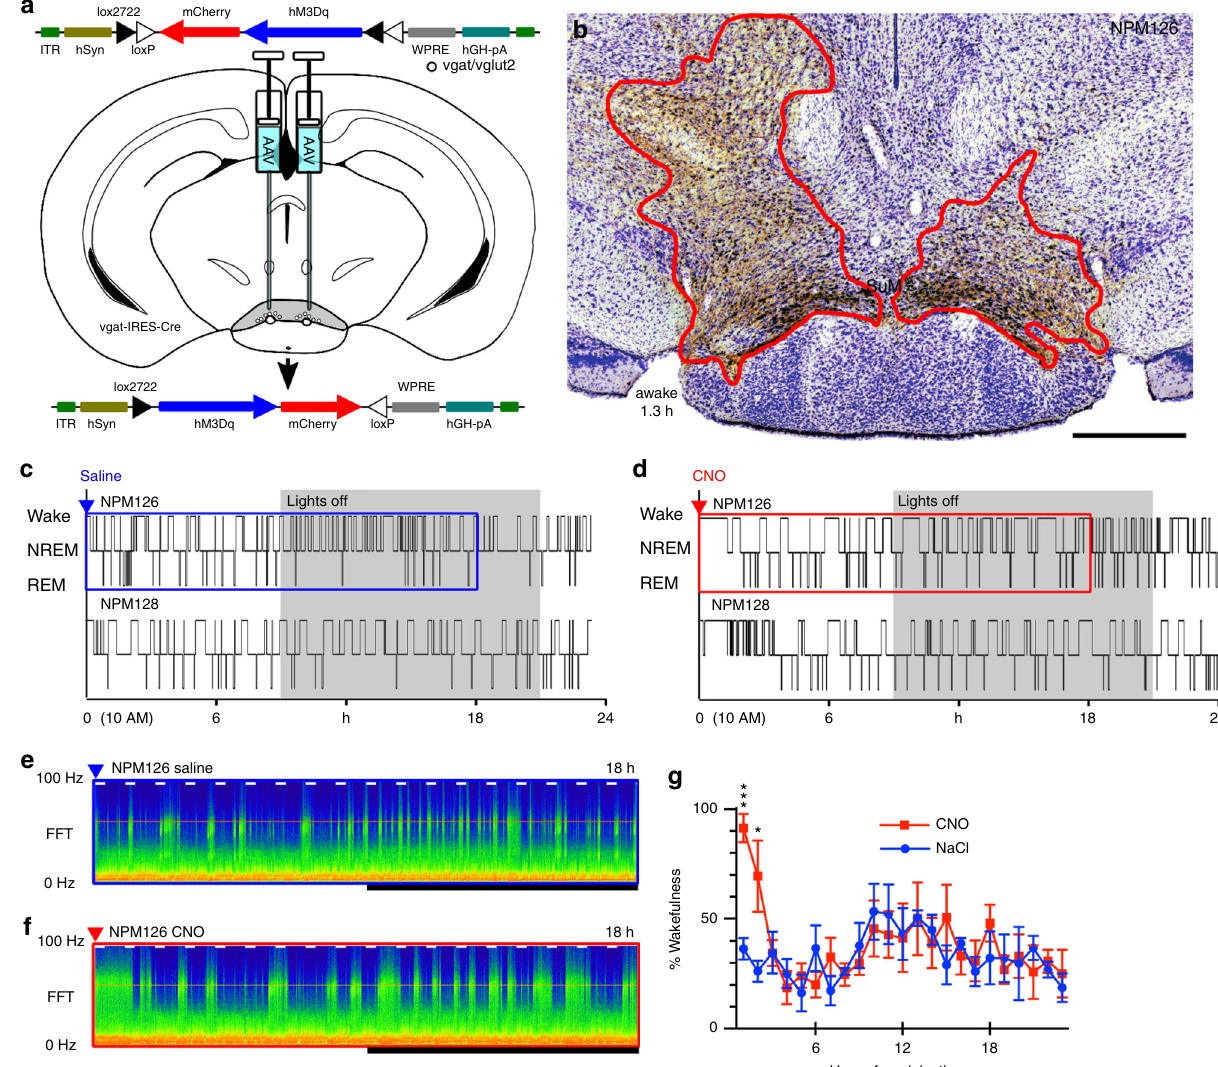
Fig. 6 Activation of SuM vgat neurons results in brief wakefulness. a Cartoon showing AAVx-FLEX-hM3Dq-mCherry recombining in vgat neurons that express Cre. b An example injection site showing hM3Dq transduction (red outline) in the region containing GABA-glutamate neurons in the SuMg (lower left — duration of wakefulness after CNO in this mouse, scale bar 500 µ m). c , d Hypnograms showing sleep − wake in two mice with saline, then CNO, with a transient increase in wakefulness. e , f Example CSA ’ s corresponding to the periods shown by the blue and red boxes in c and d , respectively (0 − 100 Hz, black bar shows the dark period, short white bars represent 20 min and are spaced 1 h